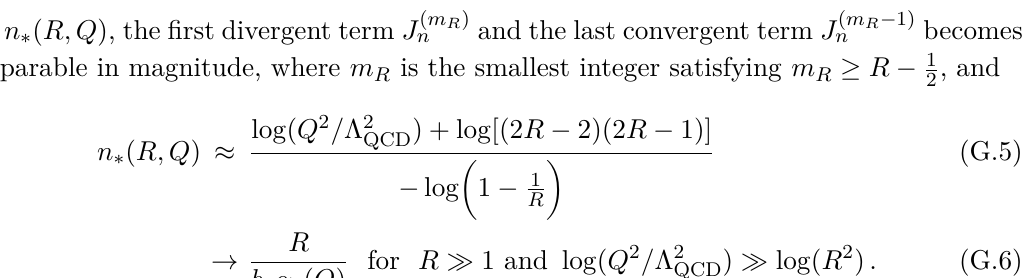
Table 2 . Numerical evaluation of the ratio | I (est) n | / | I n | for various values of n and log( Q 2 / Λ 2 This ratio is independent of R and increases rapidly from order one as n